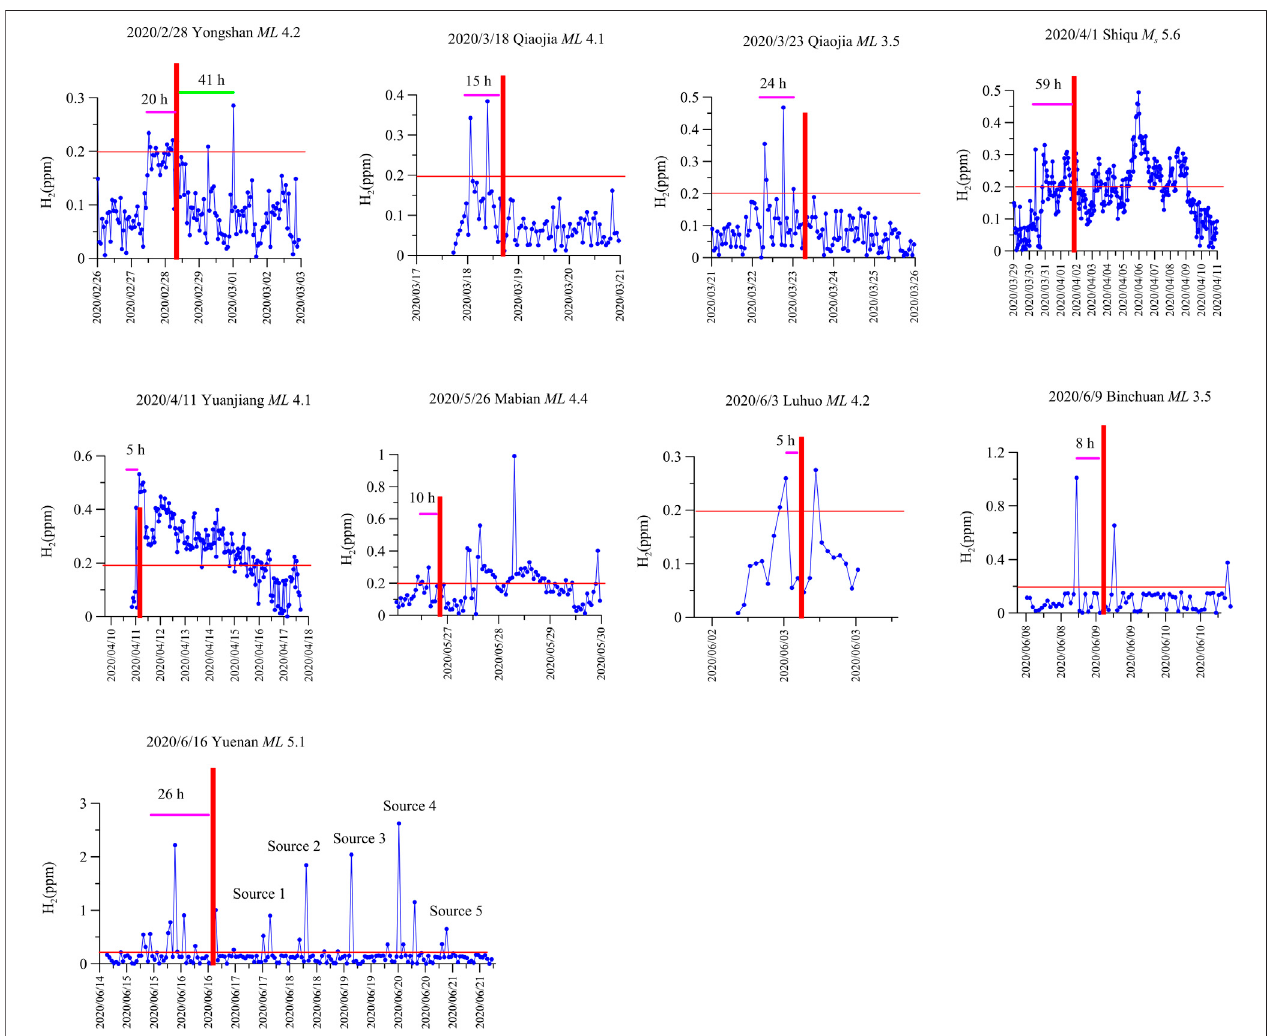
FIGURE 9 | Precursor anomalies induced by natural